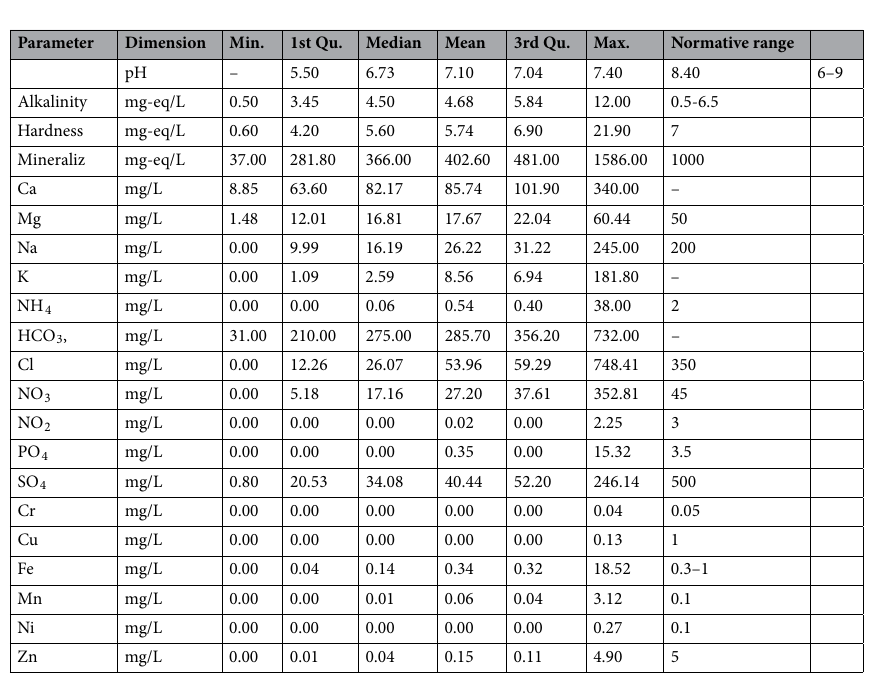
Table 1. List of parameters of study dataset and their basic statistics: minimum ( Min. ), first quartille ( 1st Qu. ), median, mean, third quartile ( 3rd Qu. ), maximum ( Max. ) and normative range, represented according to sanitary regulations in